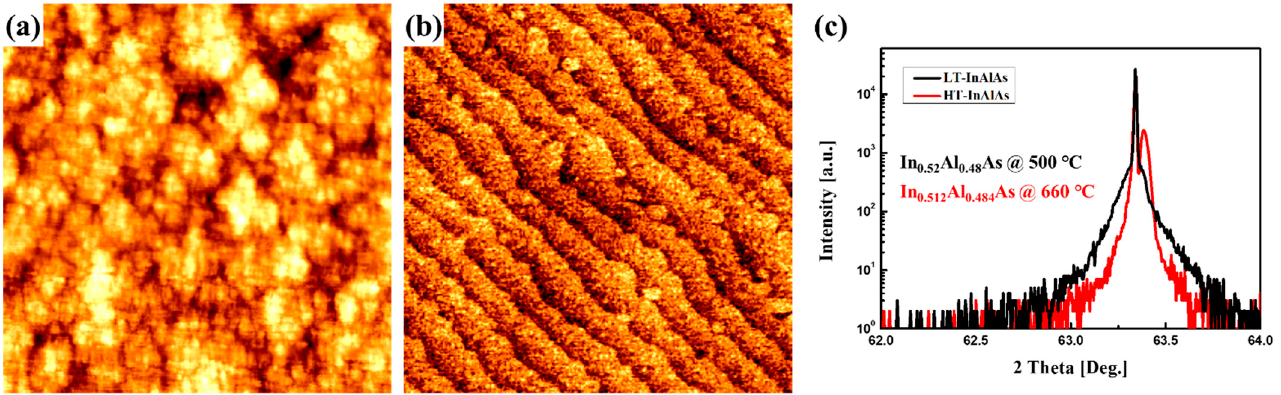
Figure 2. AFM (3 × 3 μ m 2 ) scans showing surface morphologies of InAlAs layers grown at a tem- perature of ( a ) 500 °C and ( b ) 660 °C. ( c ) Corresponding HR-XRD ω -2 θ scan data.